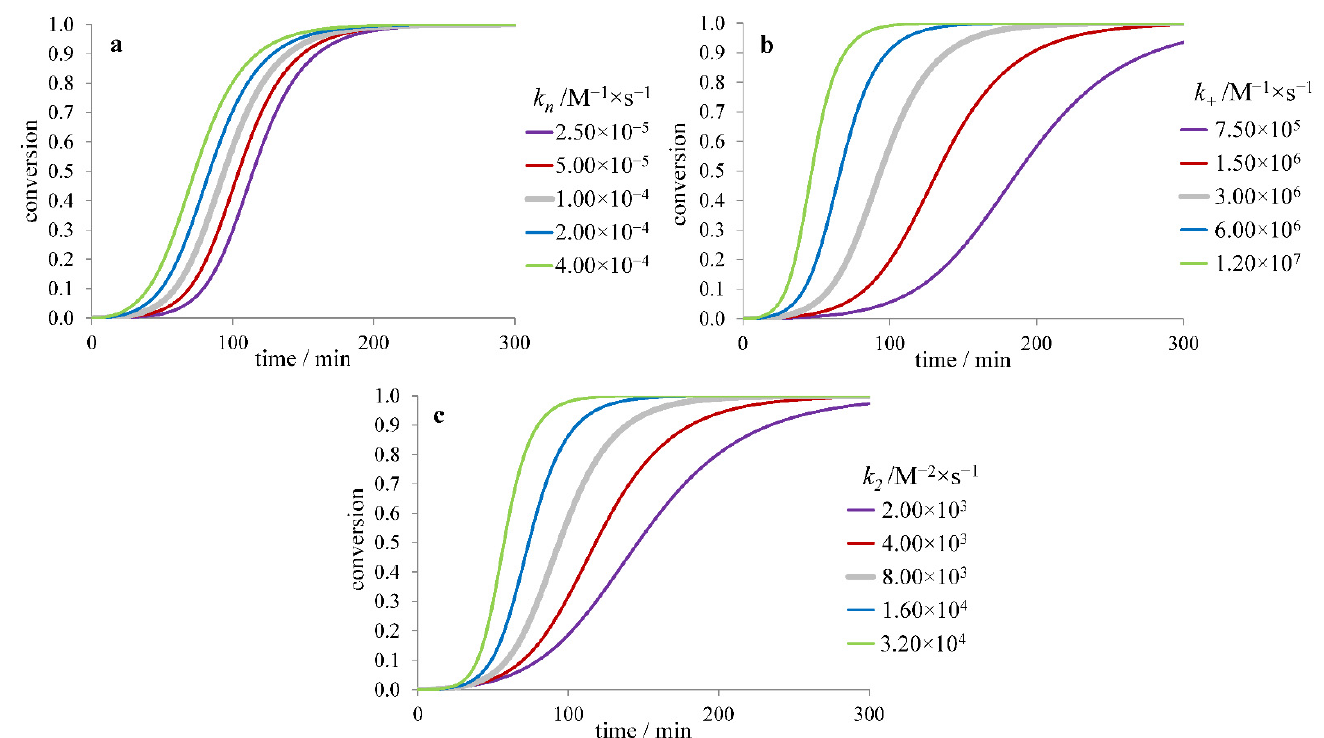
Figure 3. Dependence of the fibril formation time course on ( a ) nucleation ( k n ), ( b ) elongation ( k + ), and ( c ) secondary nucleation ( k 2 ) rate constant for the model with secondary nucleation.